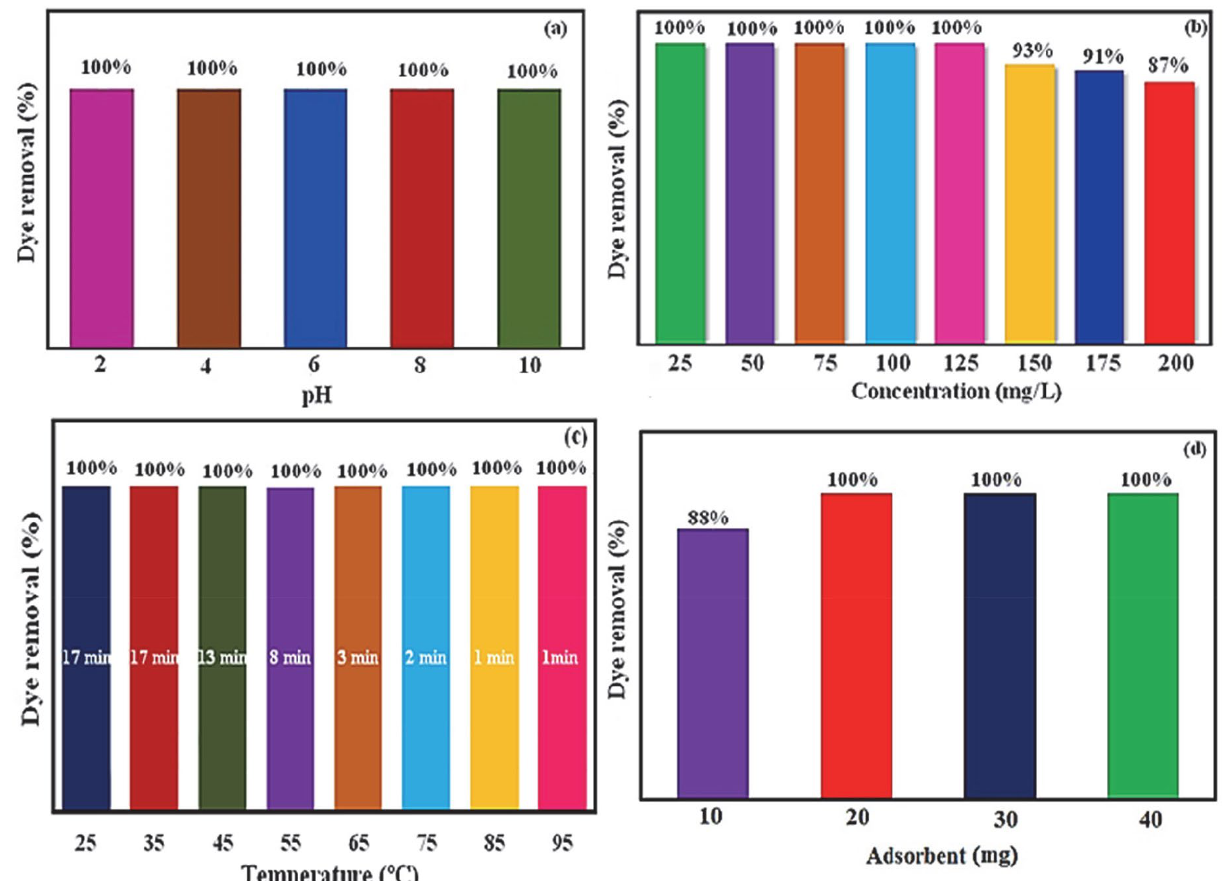
Figure 10. Effects of (a) pH, (b) dye concentration, (c) different temperatures and (d) adsorbent dosage on dyes removel by the P 2 W 18 @MIL-101(Cr) sample. Conditions: C 0 (MB) = 100 mg/L in 30 mL dye solution at 25